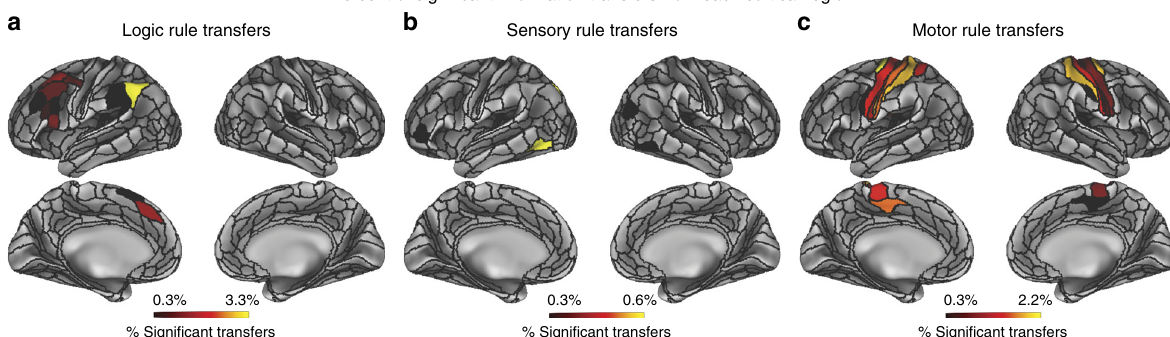
Fig. 7 Percent of statistically signi fi cant information transfers from each cortical region. All reported information transfers were statistically signi fi cant at p < 0.05 (FWE-corrected) (see Supplementary Fig. 7 for results with an FDR-corrected p < 0.05 threshold). a Percent of statistically signi fi cant information transfers from each region for the logic rule domain. Percentages were computed by taking the number of signi fi cant transfers from each region, and dividing it by the total number of possible transfers from that region (359 other regions). Information transfers were relatively distributed, yet were predominantly from frontal parietal cortices. b Percent of statistically signi fi cant information transfers from each region for the sensory rule domain. Information transfers were much sparser than in the logic rule domain. Most transfers were from higher-order visual areas and the DAN. c Percent of statistically signi fi cant information transfers from each region for the motor rule domain. Transfers were predominantly from the motor